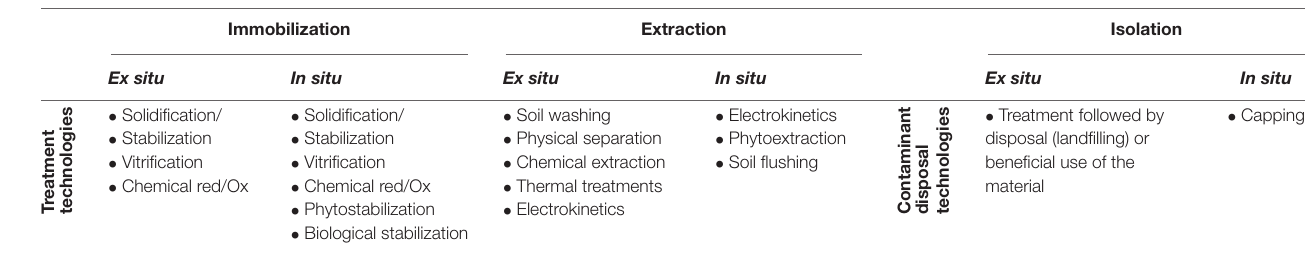
TABLE 3 | Remedial options for metal-contaminated soil (adapted from Karna et al., 2017). Immobilization Extraction